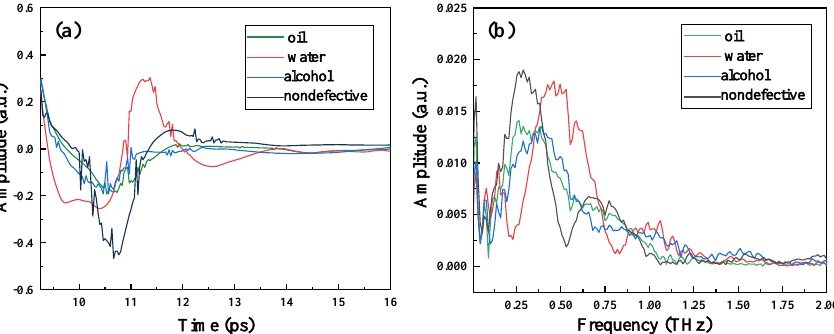
Figure 6. Terahertz signals of each liquid ingress in ( a ) time-domain in 9.25–15 ps window and ( b ) frequency-domain in 0–2 THz